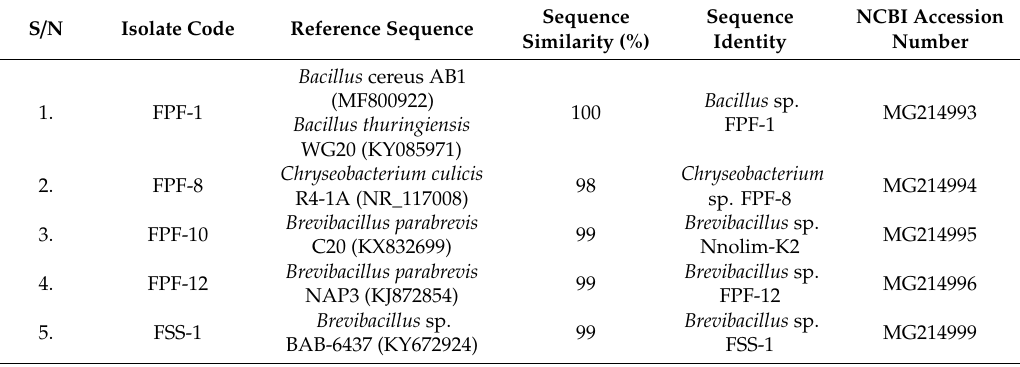
Table 1. Identification of keratinolytic bacterial isolates, using 16S rDNA